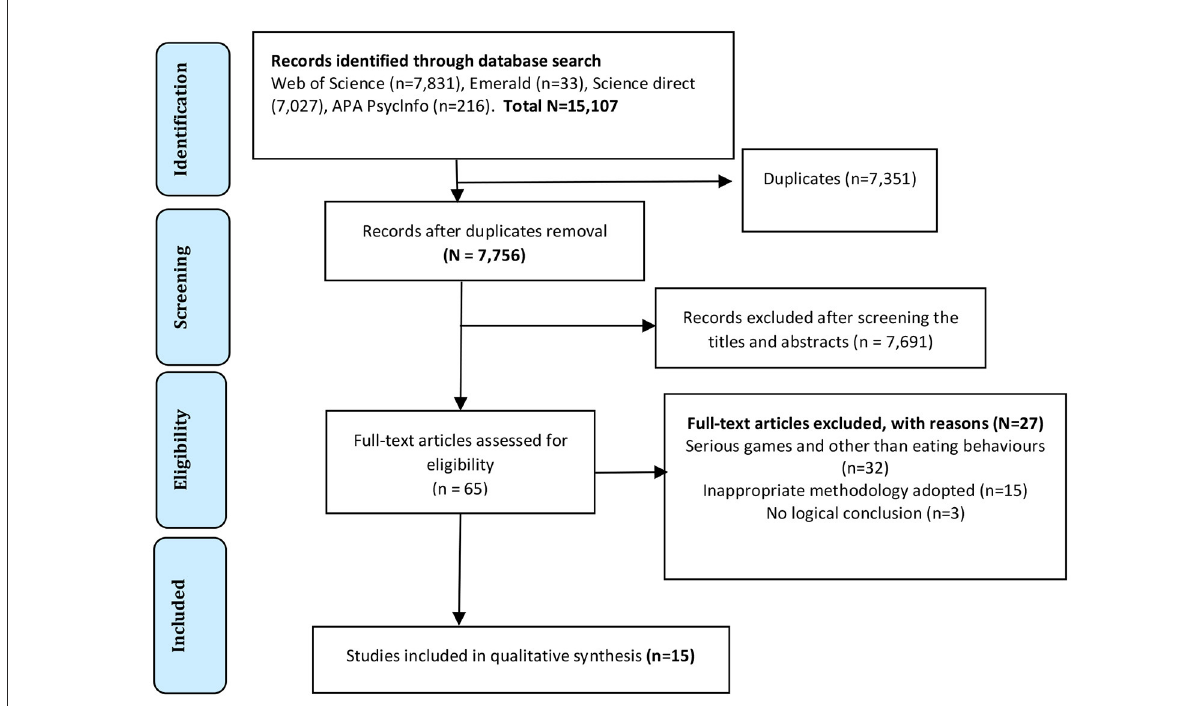
FIGURE2 PRISMA flowchart showing the screening process for the identification of relevant studies.